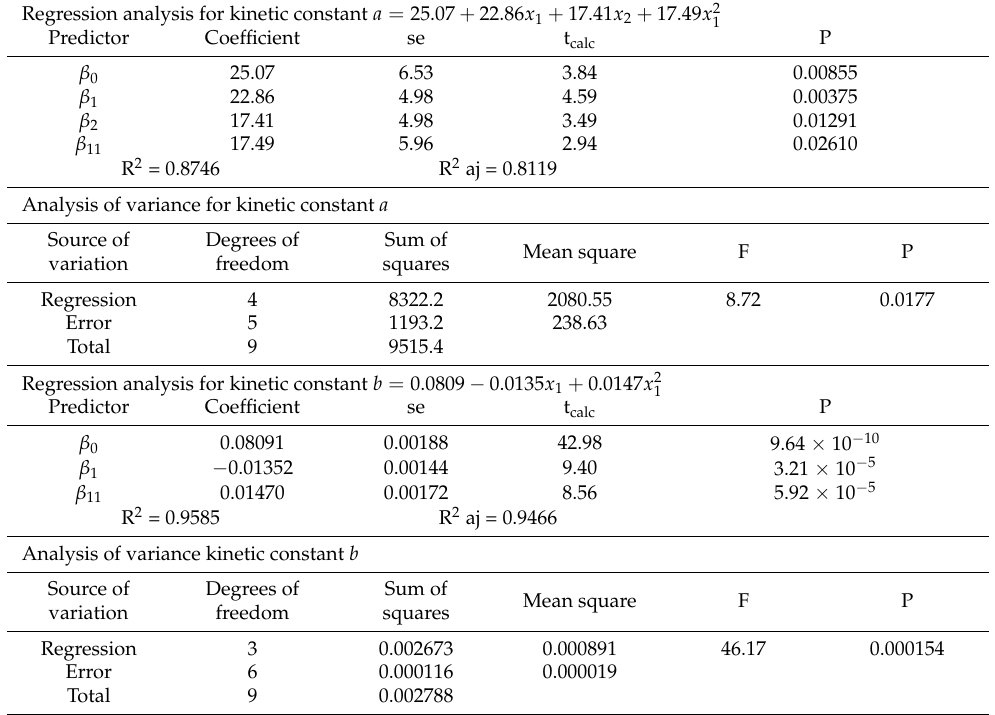
Table 4. Regression and variance analysis for RSM models for kinetic constants a and b for the enzymatic hydrolysis of milk proteins with Neutrase.